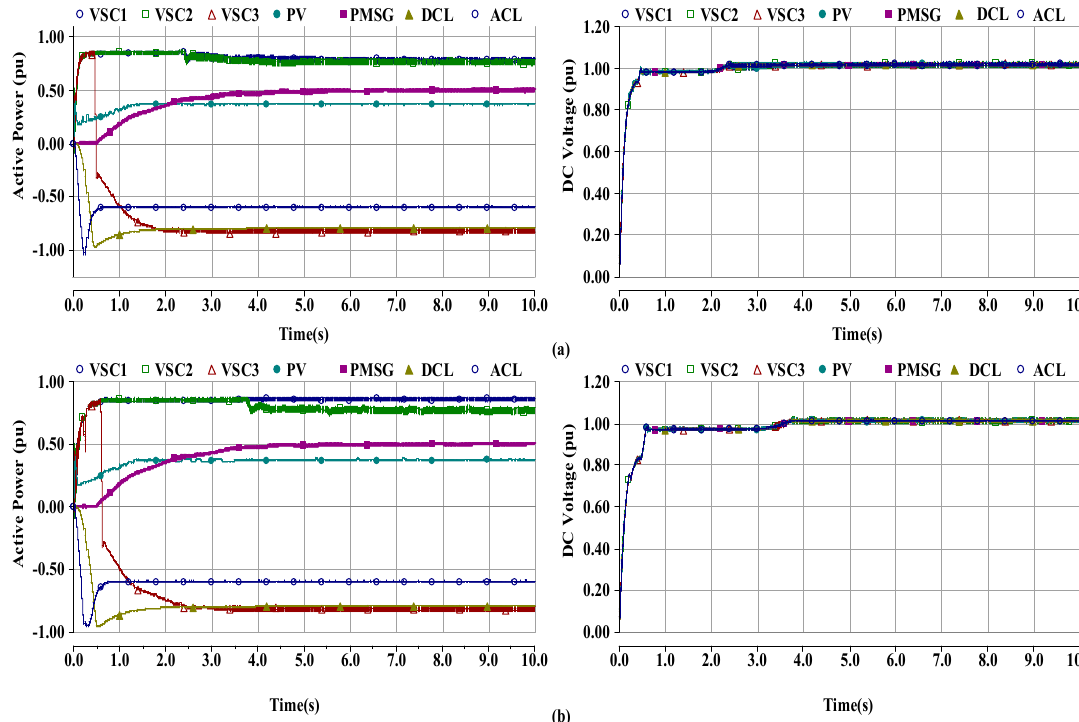
Figure 7. Active power and DC voltage of the adaptive droop with a dead-band and VSG primary controller with ( a ) non-optimal and ( b ) DC OPF secondary control.